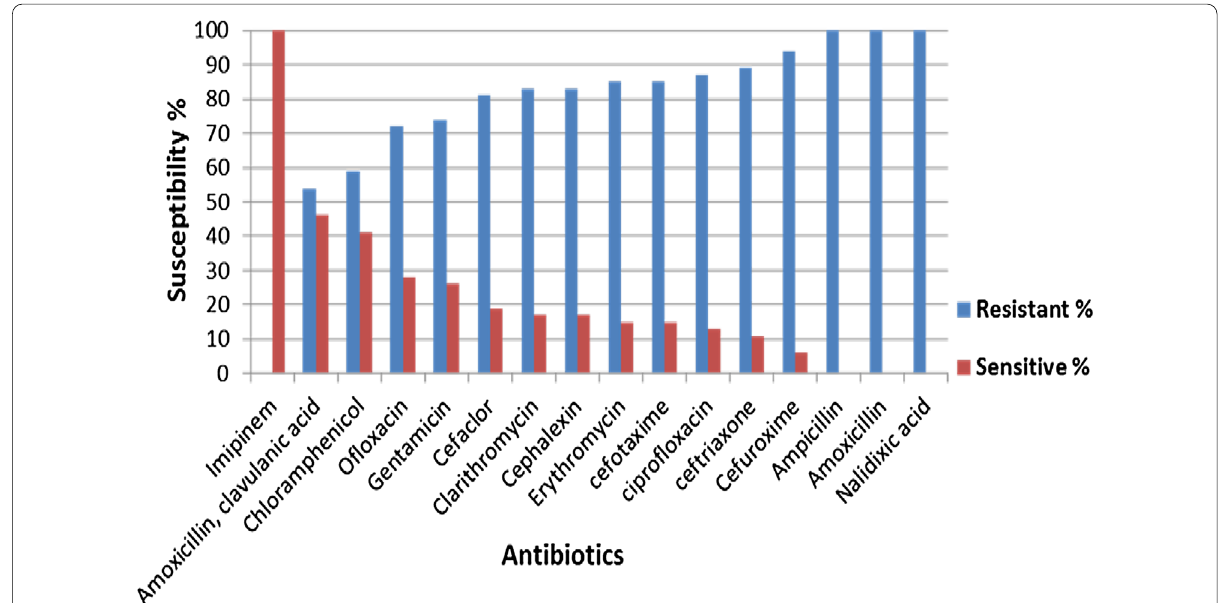
Fig. 1 Antibiotic susceptibility pattern of S. aureus isolate from clinical specimens